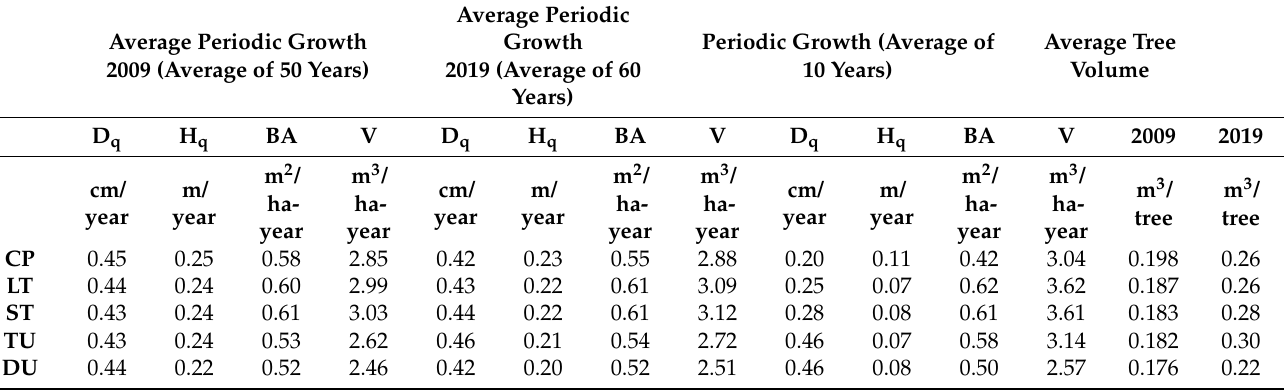
Table 2. Mean values of average periodic growth, periodic growth, and unitary volumes of the mean tree per treatment in different